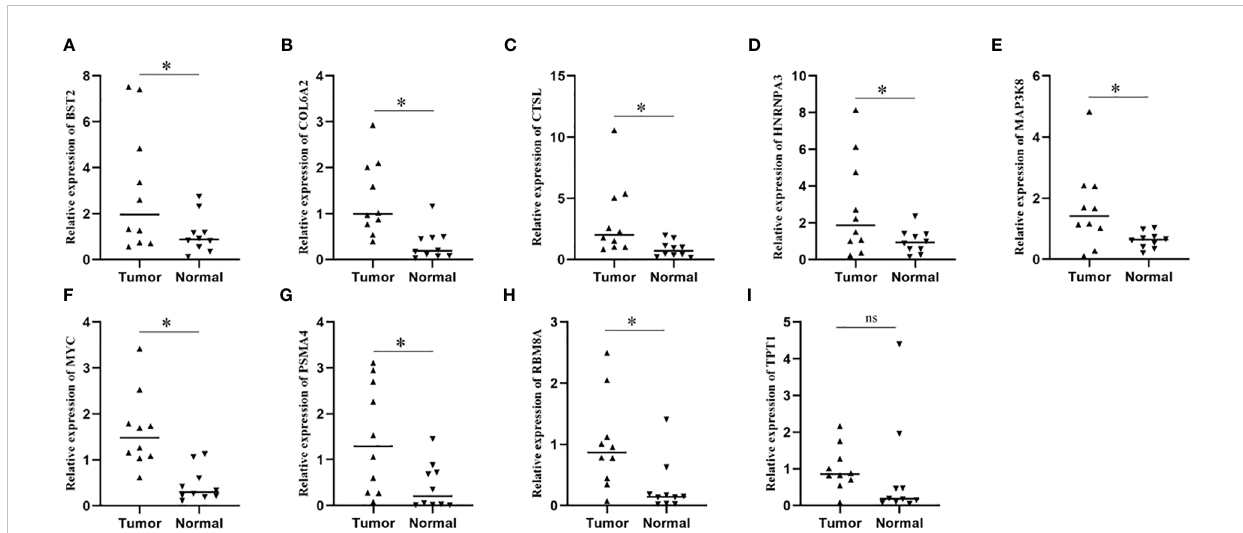
FIGURE 7 Expression levels of model genes in a real-world cohort. (A – I) qPCR assay was used to detect the transcription levels of model genes in tissue samples. * means